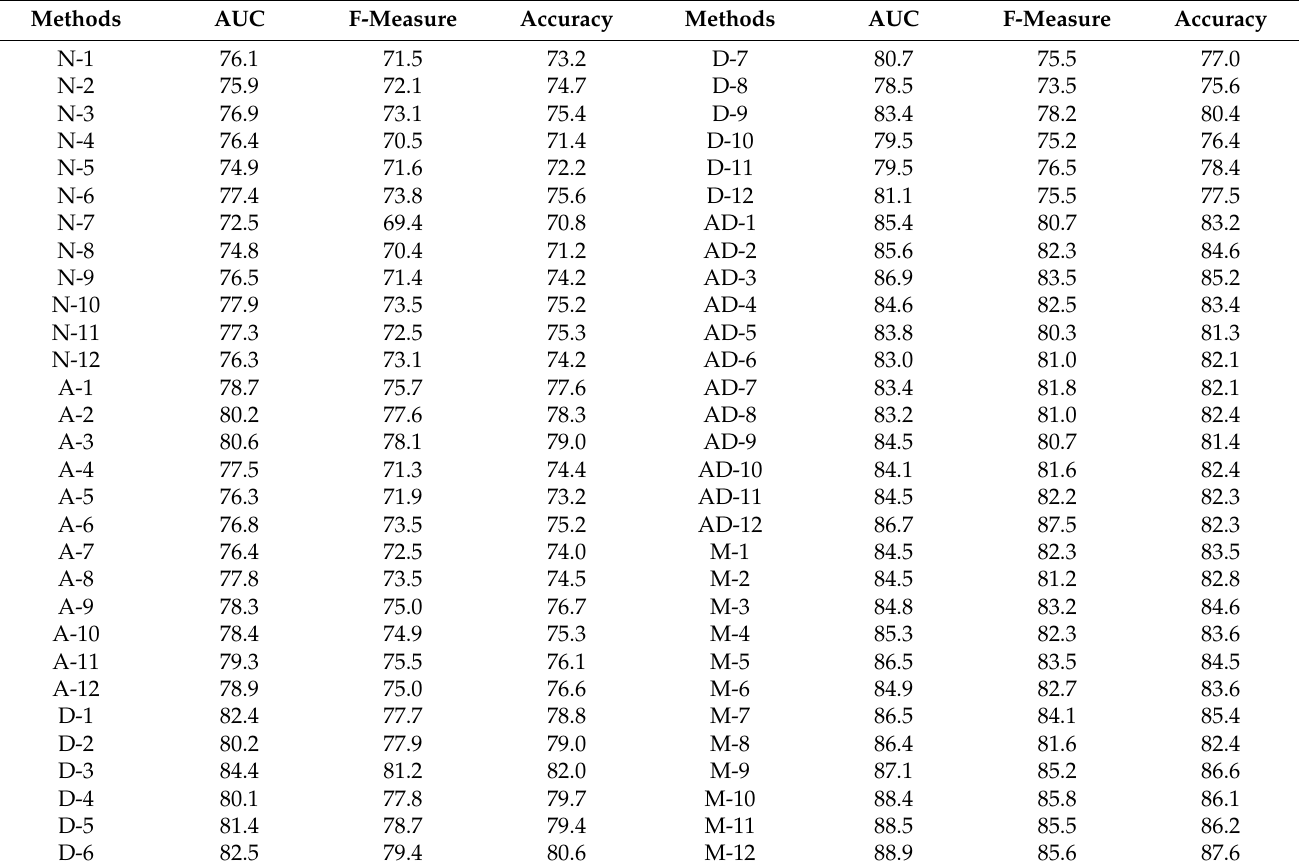
Table 6. Multi-Class Classification